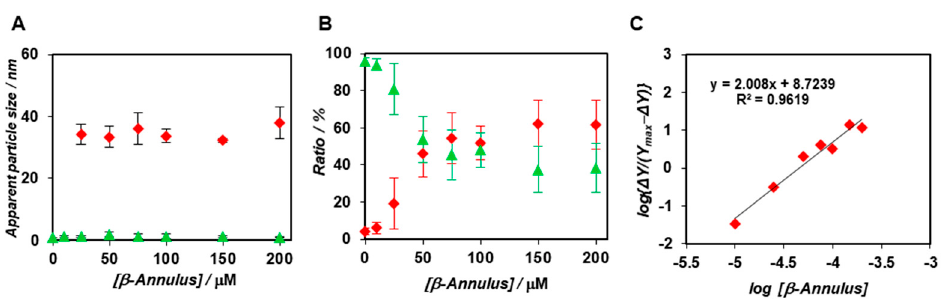
Figure 2. ( A , B ) Concentration dependence of β -annulus peptides on the apparent diameter ( A ) and ratio ( B ) of the fast component (green) to the slow component (red) determined by FCS curve fitting ( N = 3) at a constant concentration of the BODIPY- β -annulus peptide (0.1 μ M in 10 mM Tris-HCl buffer) (pH 7.0) at 25 °C. ( C ) Hill plot of binding of the β -annulus peptides to the BODIPY- β -annulus peptides in a 10 mM Tris-HCl buffer (pH 7.0). The fractions obtained from FCS analysis were fitted into the Hill equation to determine the apparent dissociation constant K d .